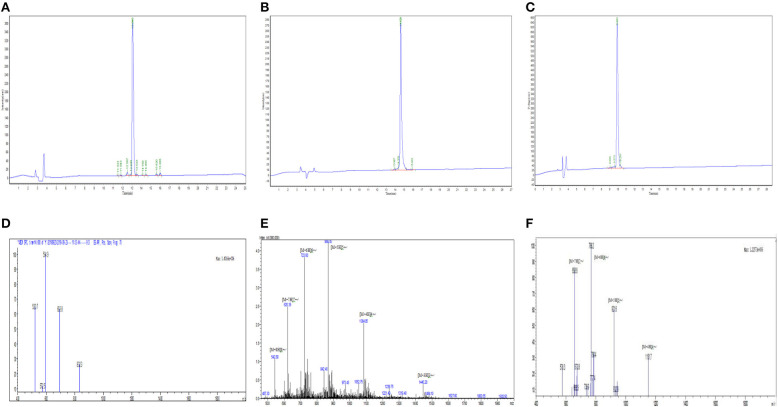
HPLC and mass spectrometry analysis of Myr-36PW and its analogs and Myr-36PW molecular structure. (A–C) HPLC of PMAP-36, PMAP-36PW, and Myr-36PW. Analytical HPLC was performed on a Waters 2690 Alliance system equipped with a Waters Gemini-NX C18 column (5 μm, 4.6 × 250 mm) at a flow rate of 1.0 mL/min using a gradient of 5–65% acetonitrile in water with 0.1% TFA as the mobile phase. UV detection was at a wavelength of 220 nm. (D–F) Mass spectrometry of PMAP-36, PMAP-36PW, and Myr-36PW. The source conditions were as follow: nebulizer gas flow: 1.5 L/min, CDL temperature: 250°C, capillary voltage: 1,500 V. T. flow: 0.2 ml/min. The mass scan was in the range of m/z 400–2,000.